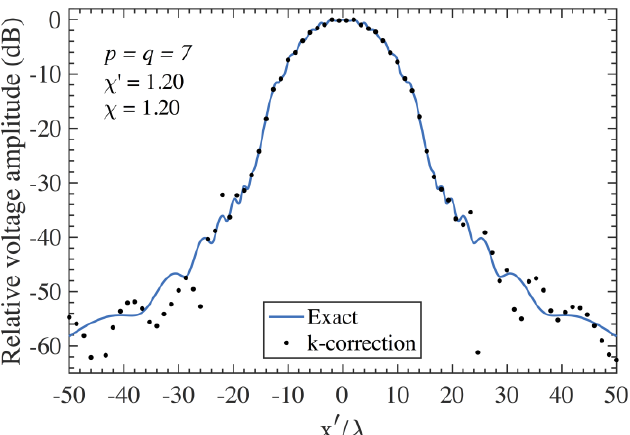
Figure 8. Amplitude of V y on the scanning plane at y ' = 3 λ − AUT 2. Blue line: exact. Black dots: attained from the positioning errors affected PWMS samples by using only the k-correction .